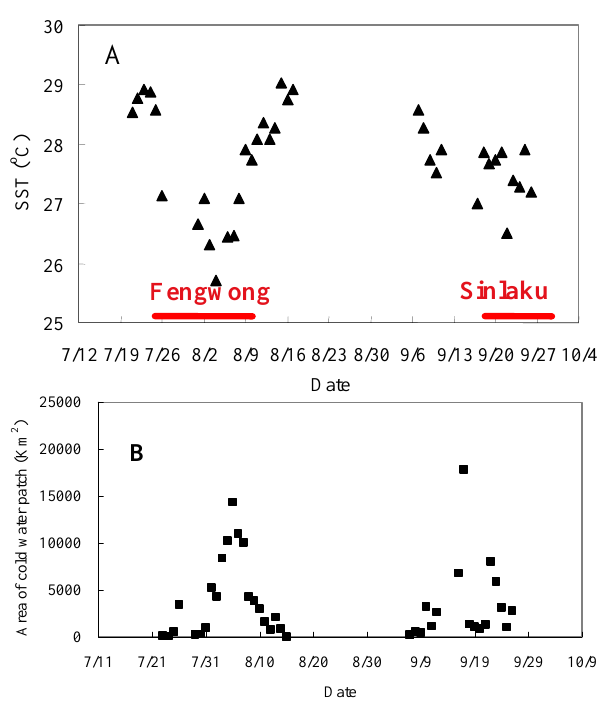
Fig. 2. (A) Sea surface temperature (SST) and (B) the area of cold water patch (e.g. SST < 27 ◦ C) in the southern East China Sea (be- tween 25.2–25.7N ◦ and 122.1 to 122.6E ◦ ) . Each datum point rep- resents the average daily value. The red line represents the influ- enced periods of pre- and post-typhoon.